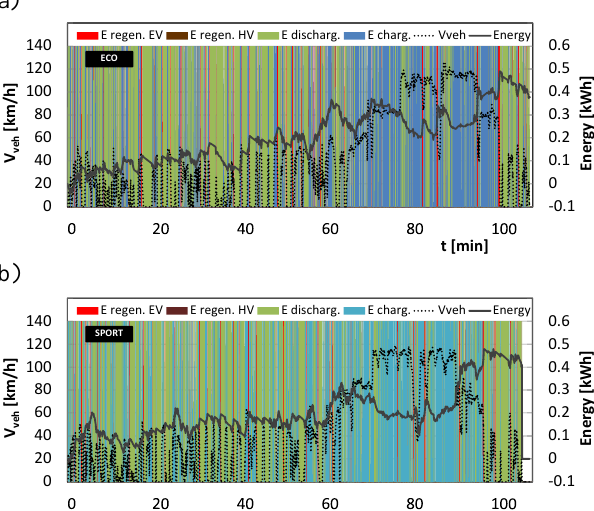
Fig. 10. Energy flow with flow conditions determined using equations (1) – (5) with the background showing the vehicle travel speed: a) in ECO